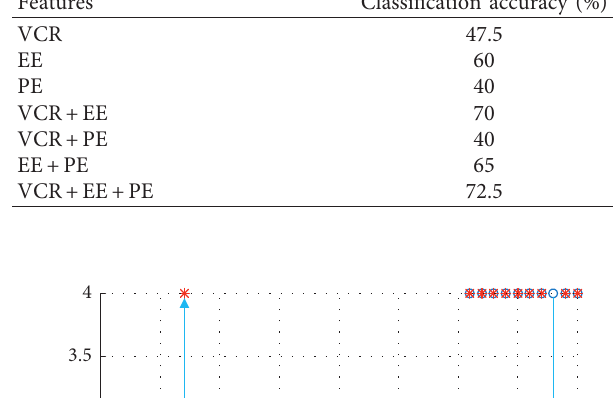
Table 7: The classification accuracy of the classifier. Features